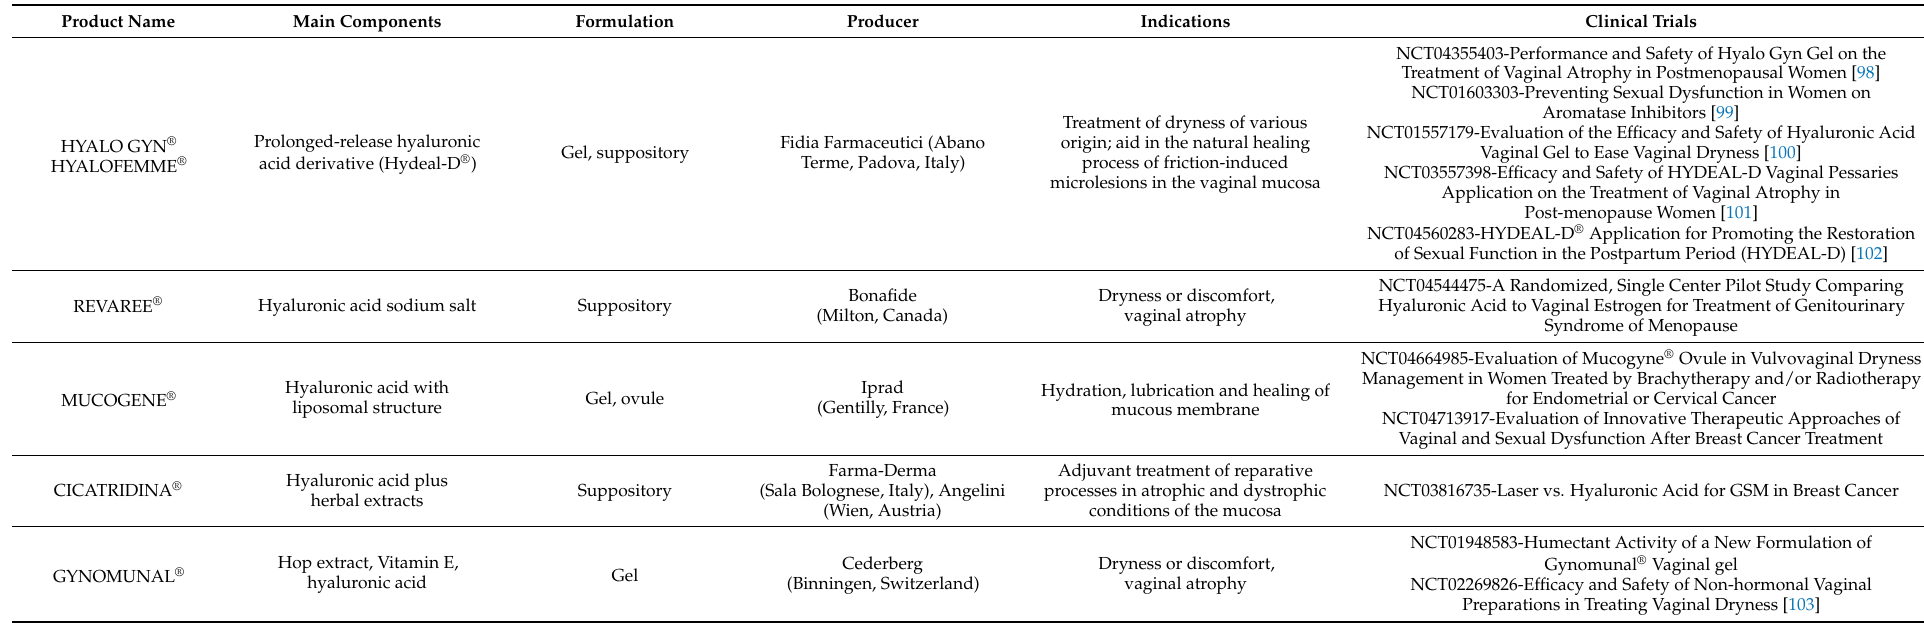
Table 1. Hyaluronic acid (HA)-based vaginal products available for the treatment of